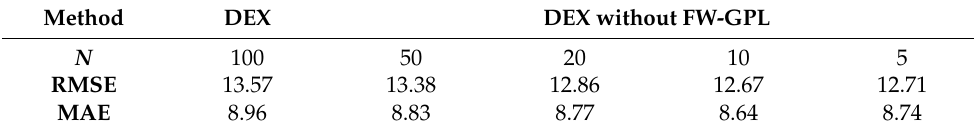
Table 7. Test performance of the DEX method (set length of output neurons N as [100, 50, 20, 10,